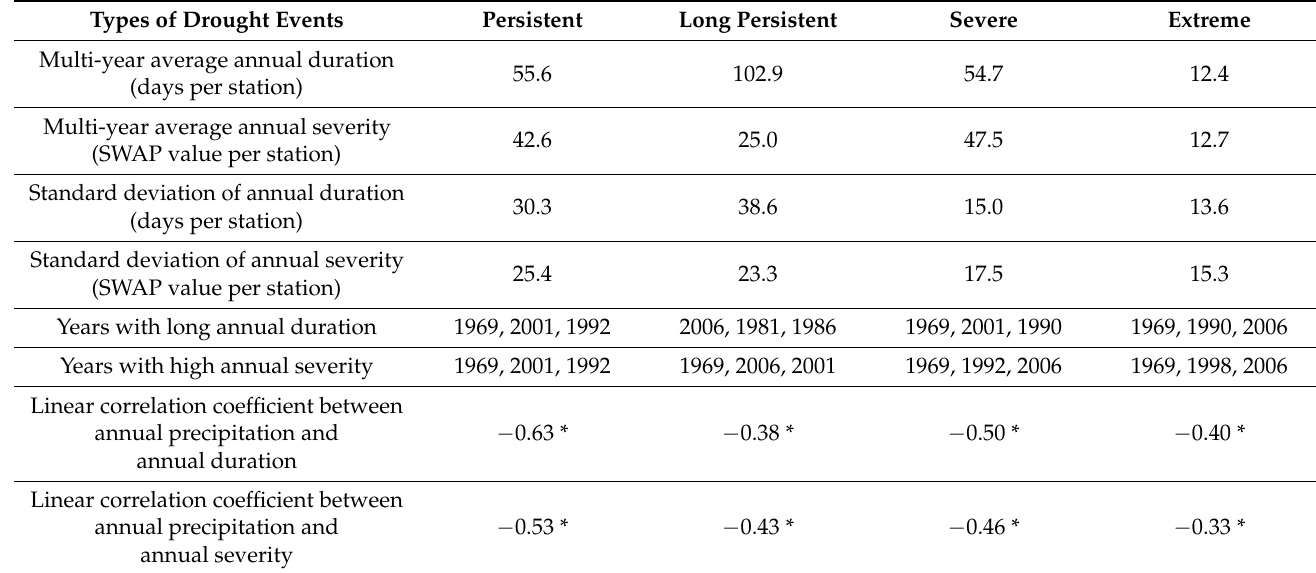
Table 4. The temporal characteristics of annual duration and severity of persistent, long persistent, severe, and extreme drought events from 1960 to 2015.